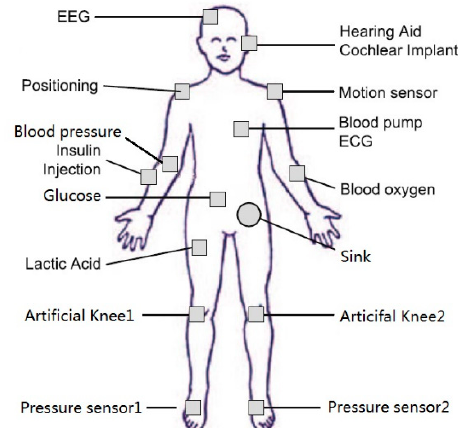
Figure 1. Distributed sample of wireless body area network sensors.